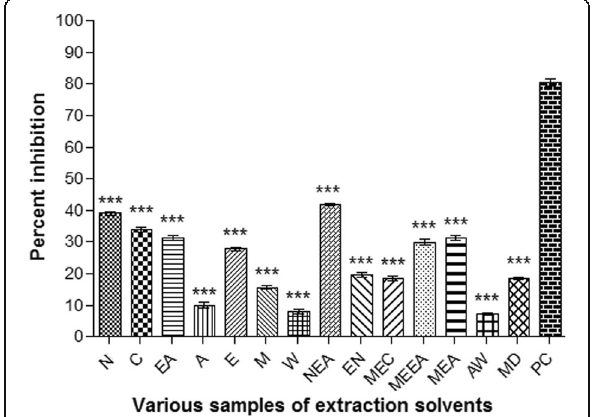
Fig. 5 Percent α -amylase inhibitory potential of various samples of extraction solvents. Results were presented as mean ± S.D.; n = 3, ***: